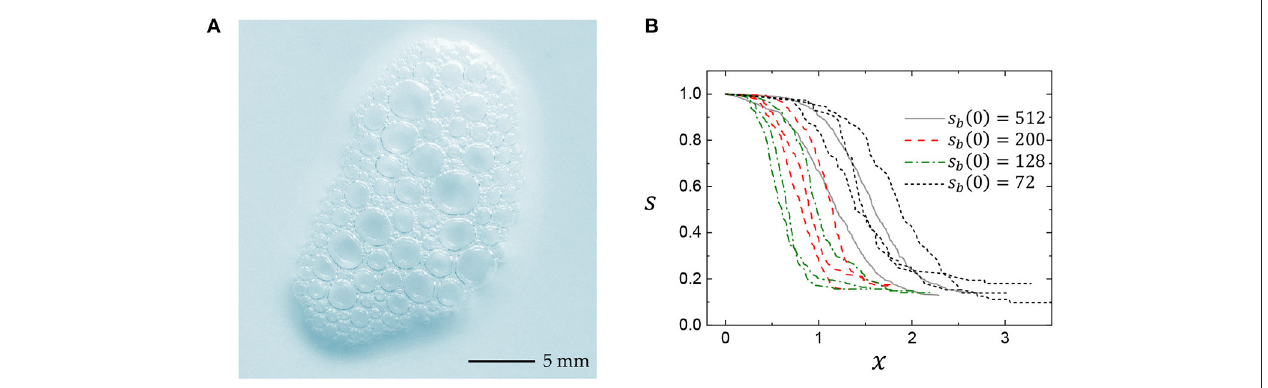
FIGURE 1 | Foam coalescence. (A) Soap foam taken in a kitchen. (B) Bubble population dynamics of sequential coalescence events in clean foams from simulation results, reproduced by Dr. Peter Stewart (personal communication, see the Dataset 1 ) based on a network model [10] (see details on data collection and analysis in the Supplementary Note ): showing the time-dependent changes in bubble numbers. The current number of bubbles is normalized by the initial number as s ( x ) = s b ( x ) / s b (0), so that 0 ≤ s ( x ) ≤ 1. The time after the first rupture time ( t r ) is rescaled as x = t − t r . The data for s b (0) = 72, 128, 200, and 512 were taken from a range of models: the datasets for 200 and 512 bubbles were generated using a simpler model than those for 72 and 128.